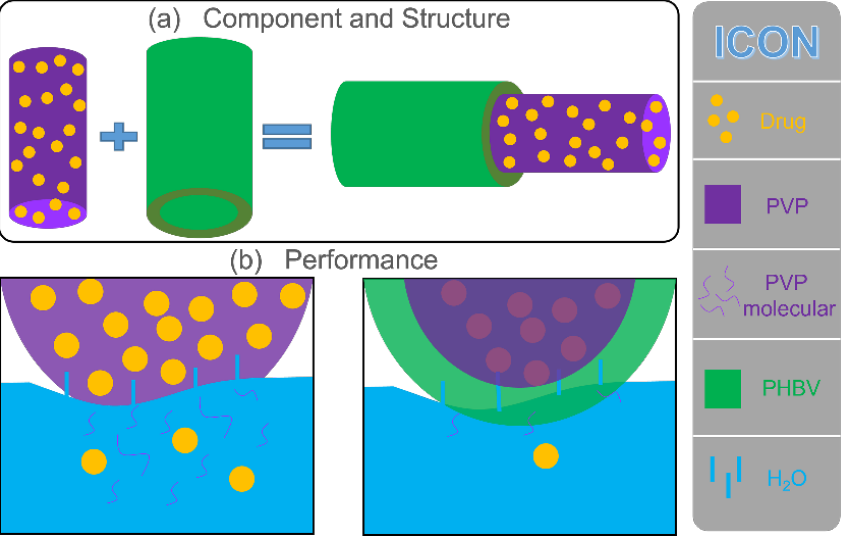
Figure 6. Mechanism of drug release in F1 and F2 fibers. ( a ) Component and structure of F1 and F2 fibers. ( b ) Schematic of the drug release of F1 and F2 fibers in water. F2 fibers. ( b ) Schematic of the drug release of F1 and F2 fibers in